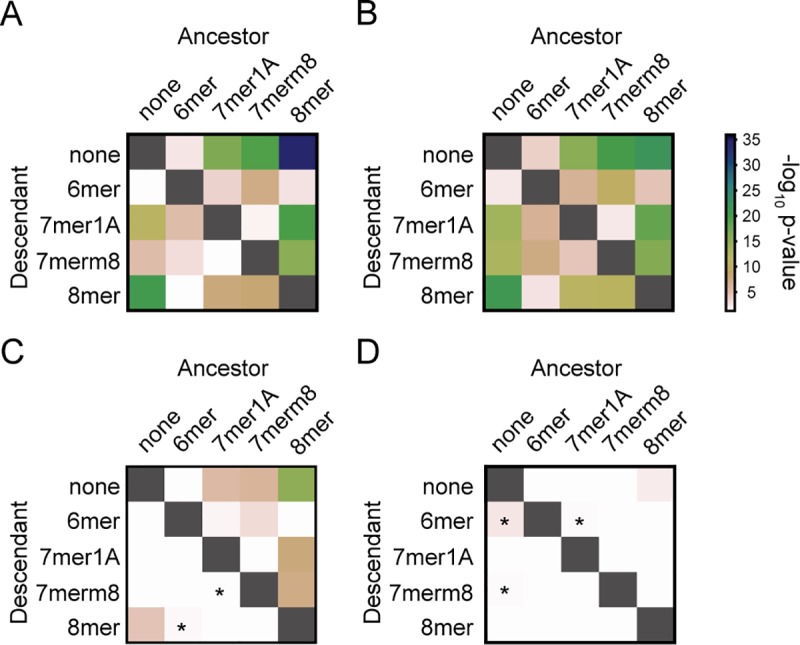
Interconversions that strengthen or weaken miRNA target sites are disfavored.Each panel calculates pairwise comparisons between the foreground and background rates at which the indicated miRNA target sites undergo substitutions (see methods). The ancestral target site type is represented along the x-axis, and the descendant along the y-axis. Substitutions that increase the average strength of a target site are below and to the left of the diagonal (grey boxes), while substitutions that decrease the average strength are above and to the right. Significance is color-coded (see legend) and plotted as -log10(P-value), using Wilcoxon rank-sum comparisons between the background (all 8mers) and foreground (miRNA sequences) rates. Insignificant P-values (P>0.05) are color coded white, and significant P-values that favor strengthening or weakening of miRNA target sites (most of which are only nominally significant, and not significant with a multiple comparison correction) are marked with an asterisk. (A) Analysis of target site conversion events for all 75 deeply conserved vertebrate miRNAs (B, C, D) Analysis of target site conversion events for deeply conserved miRNAs with strong selection against both gain and loss events in their target sites (B; referred to as group 1 in the main text), deeply conserved miRNAs with strong selection against loss events but not gain events (C; group 2), and deeply conserved miRNAs with no strong selection against loss or gain events (D, group 3).